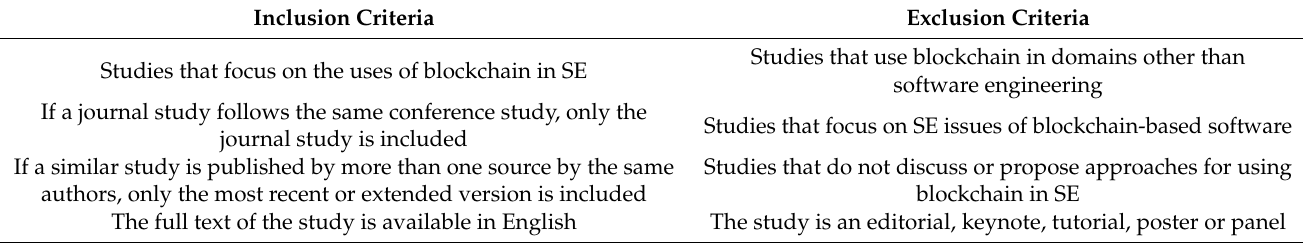
Table 1. Inclusion and exclusion